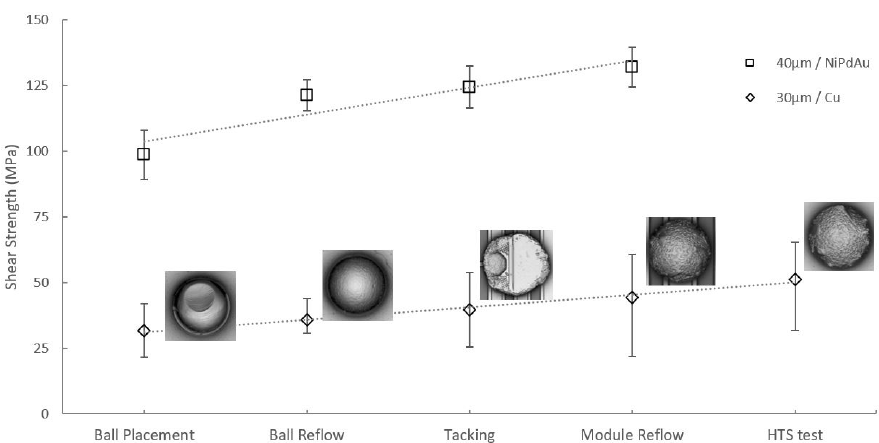
Figure 15. Comparison of shear strengths between Cu30/100 with 30µm solder spheres and NiPdAu- UBM samples with 40µm solder spheres. Each point presents a mean of at least 100 sheared balls from four different